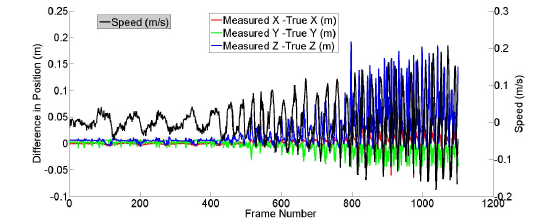
Figure 8: Evaluation of the tracking process while varying the speed of the hand movement in the transverse plane.